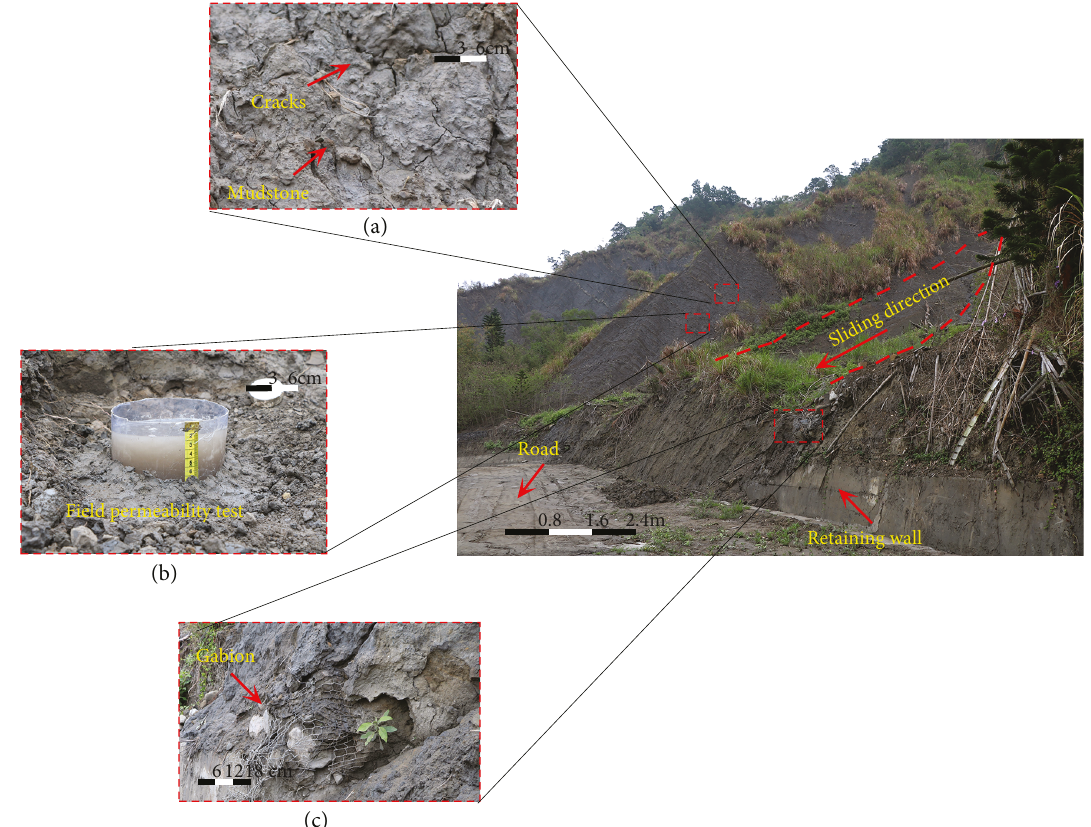
Figure 2: (a) The geomaterials of the study area, (b) fi eld permeability test (after Hoek and Bray [33]), and (c) the condition of retaining the structure after the failure.